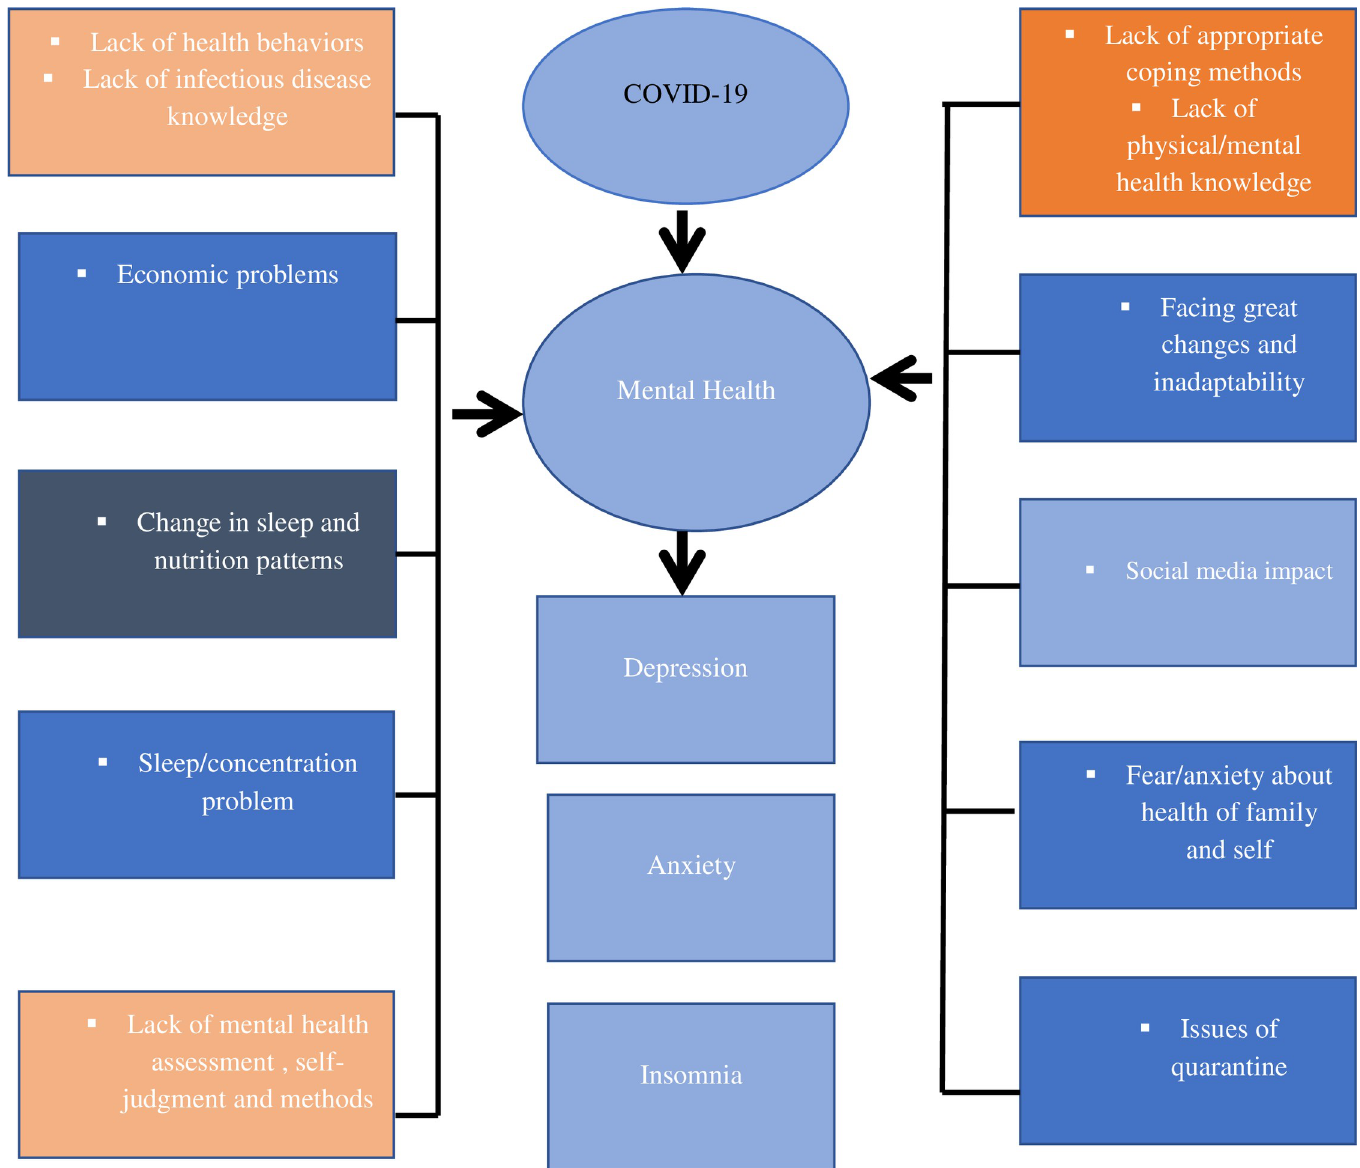
Fig 1. A figure showing the factors that increase the vulnerability to the mental and psychological impact of COVID-19.